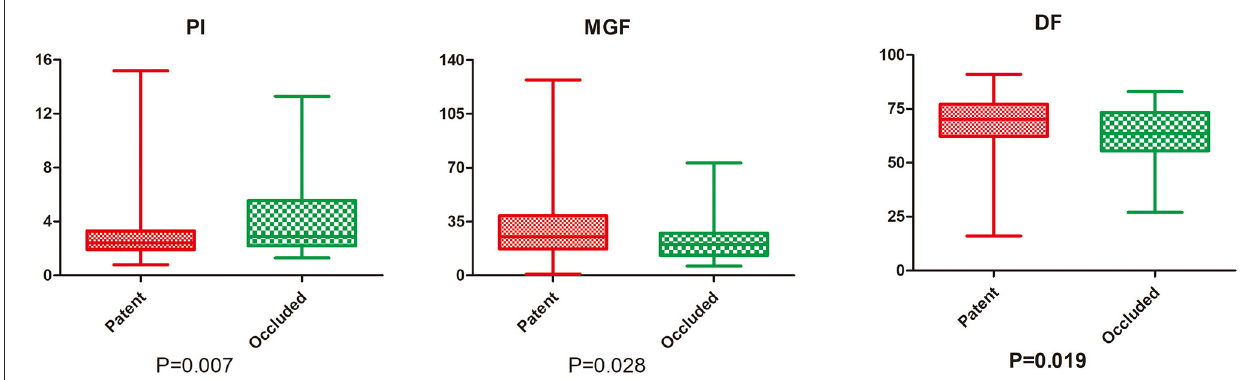
within 1 year after CABG. Demographic and baseline clinical characteristics of patients in both the patent and the occluded groups are shown in Table 1 . There were no differences between of baseline clinical characteristics. However, the occluded group had twice the amount of left main disease (45.5 vs. 21.4%, P =